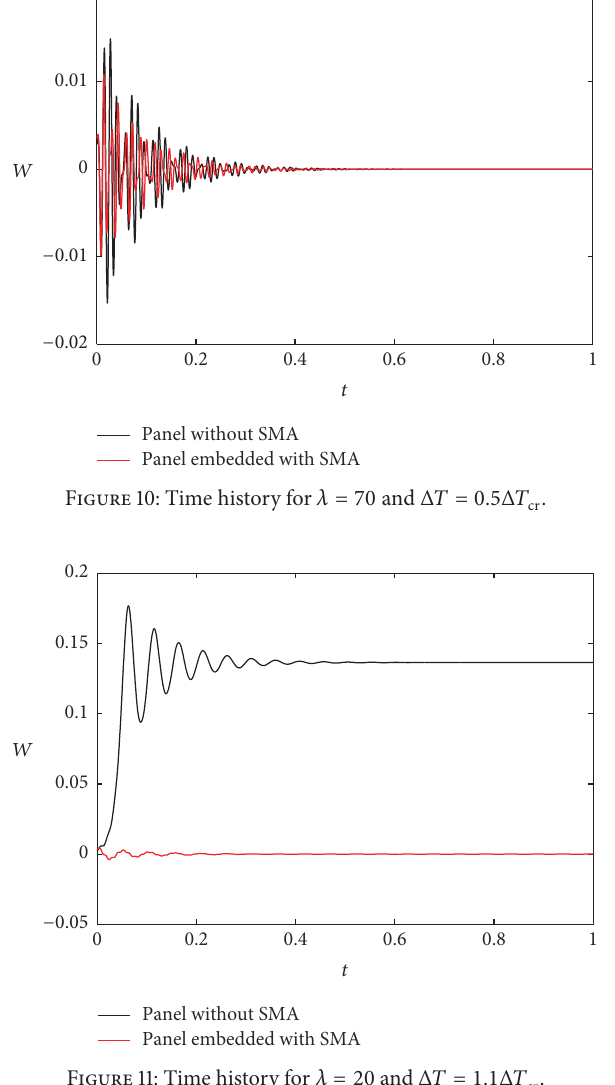
Figure 9: Stability margins.